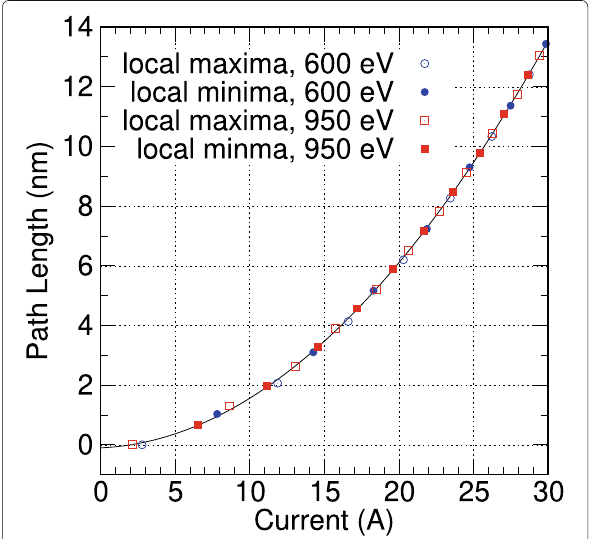
Fig. 19 Flux from ID1 and ID3 as a function of the current of EMPS1. (cid:2) ω = 600 eV and (cid:2) ω = 950 eV were chosen